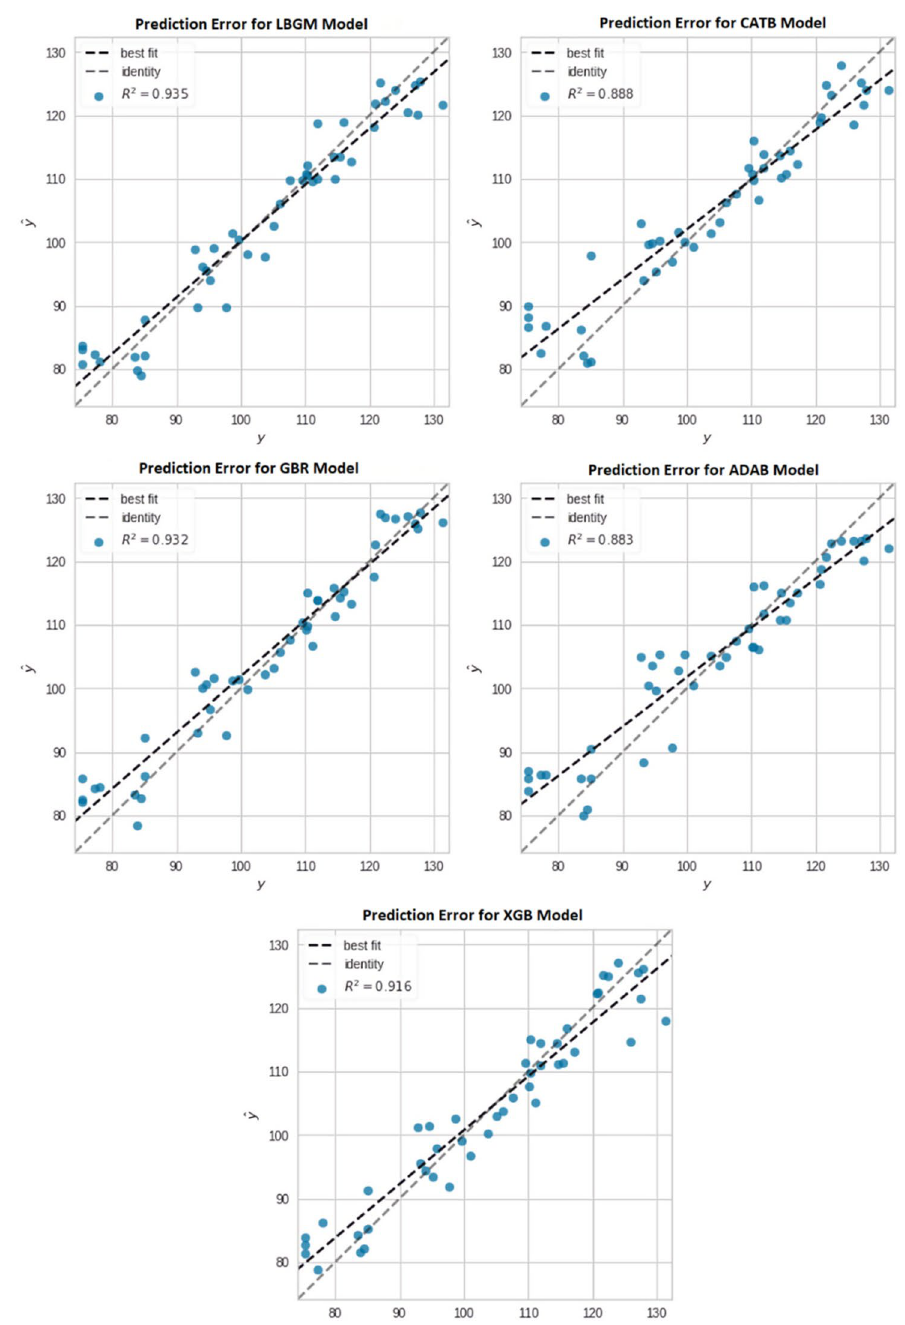
Figure 7. Best fit line for prediction distribution (RS